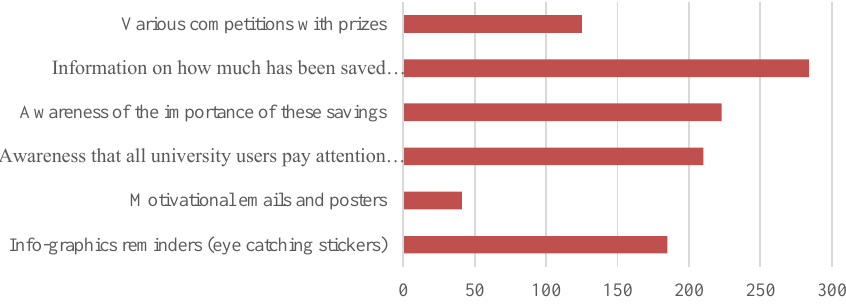
Fig. 4. Answers the survey's question: ‘What would motivate you to reduce your water and electricity consumption